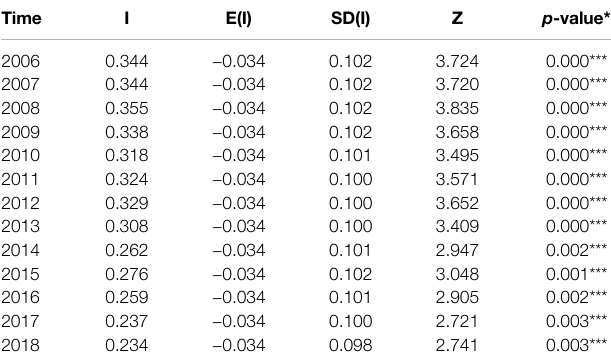
TABLE 3 | Moran ’ s I for low-carbon